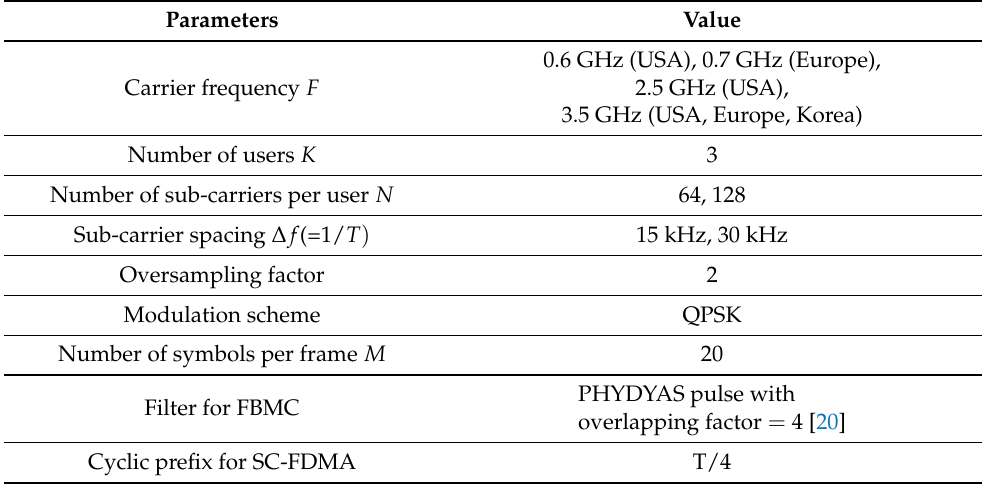
Table 2. Major system